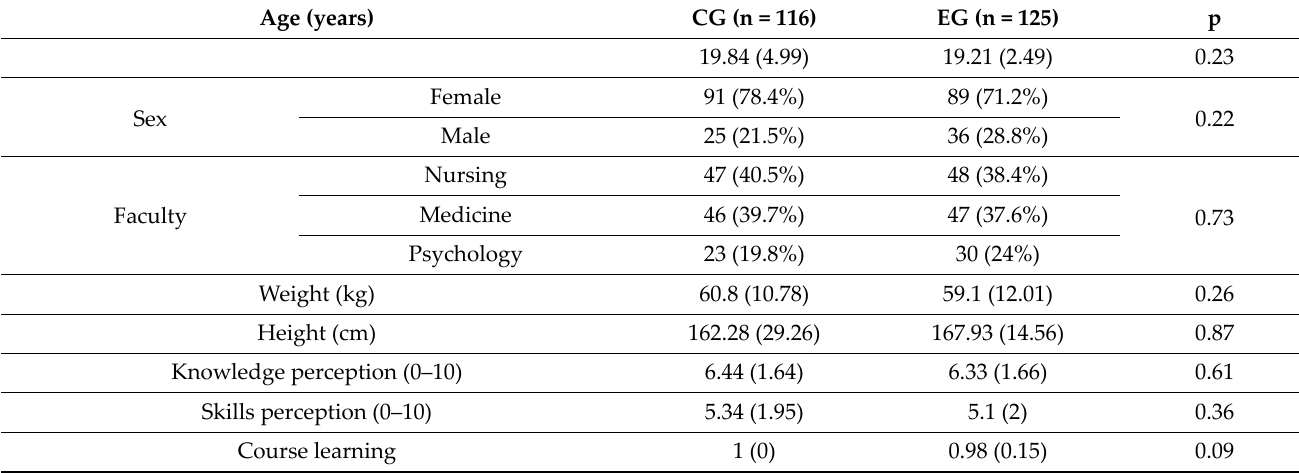
Table 2. Sociodemographic characteristics of the participants.